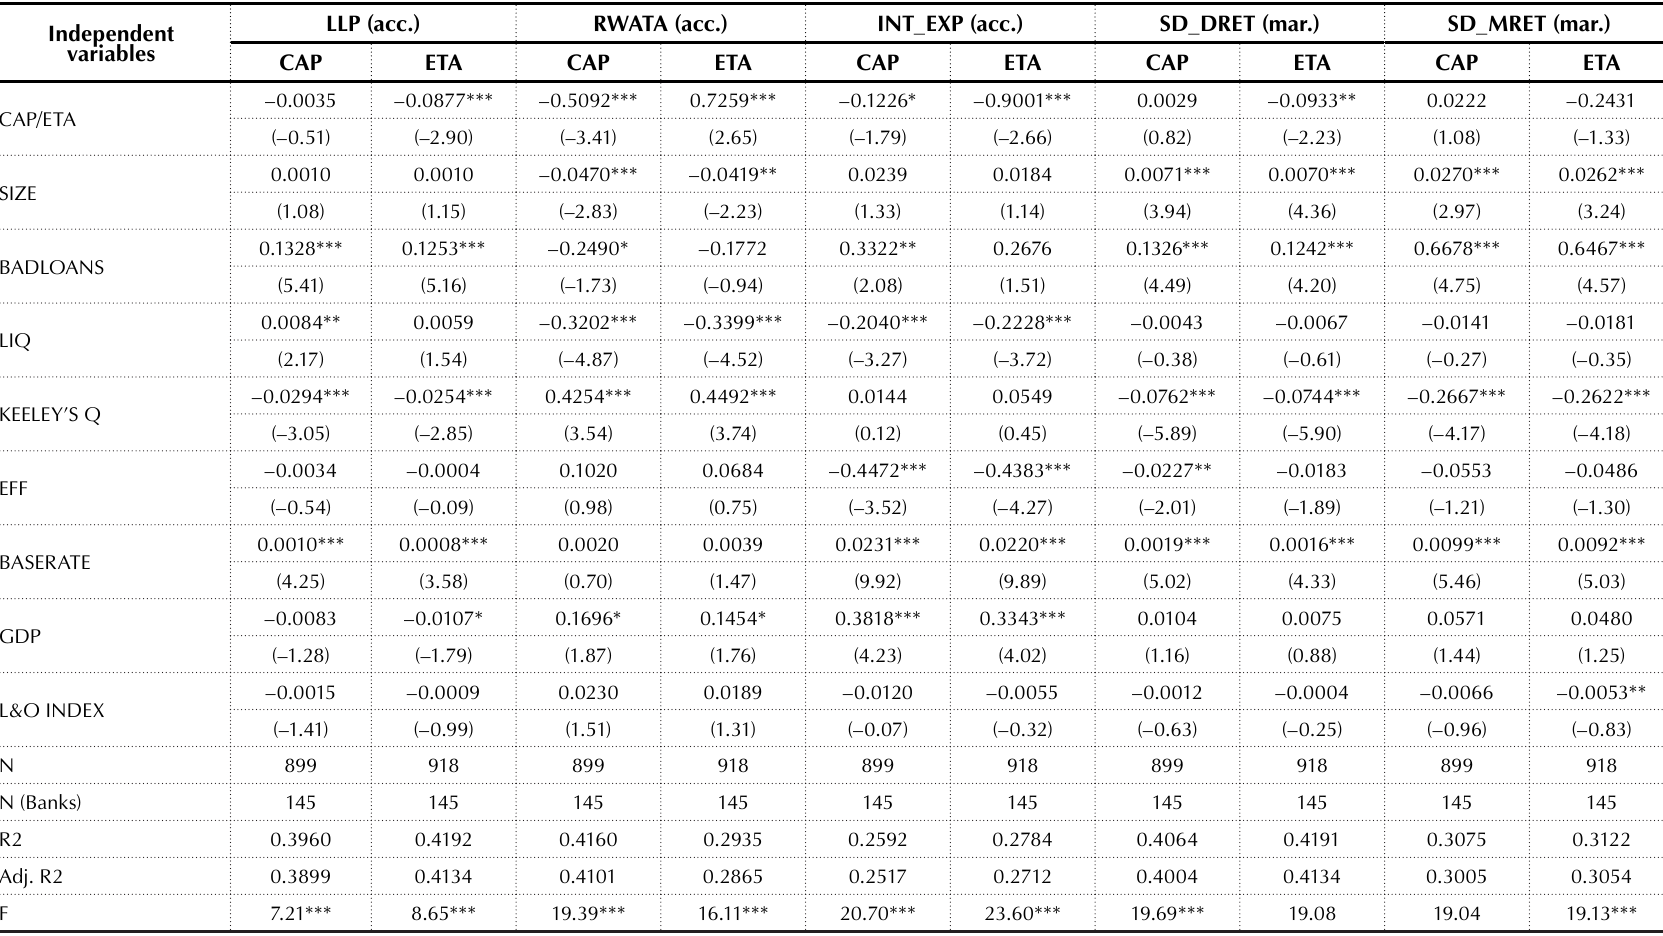
Table 6b. Regression results for accounting and market-based risk measures for the European bank market from 1992 to 2012 Independent